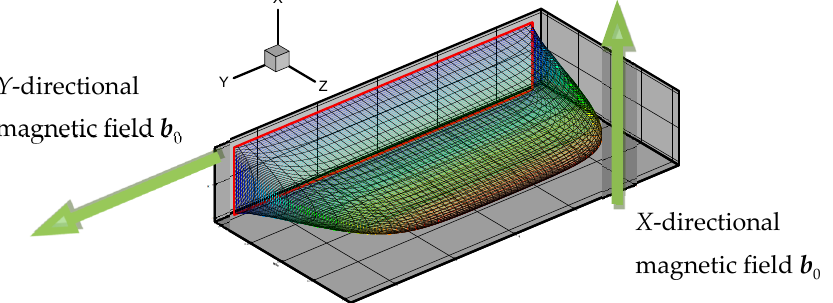
Figure 1. Sketch of the duct flow problem with uniform magnetic field imposed either in X - or Y -direction. All four side walls are electrically insulating.